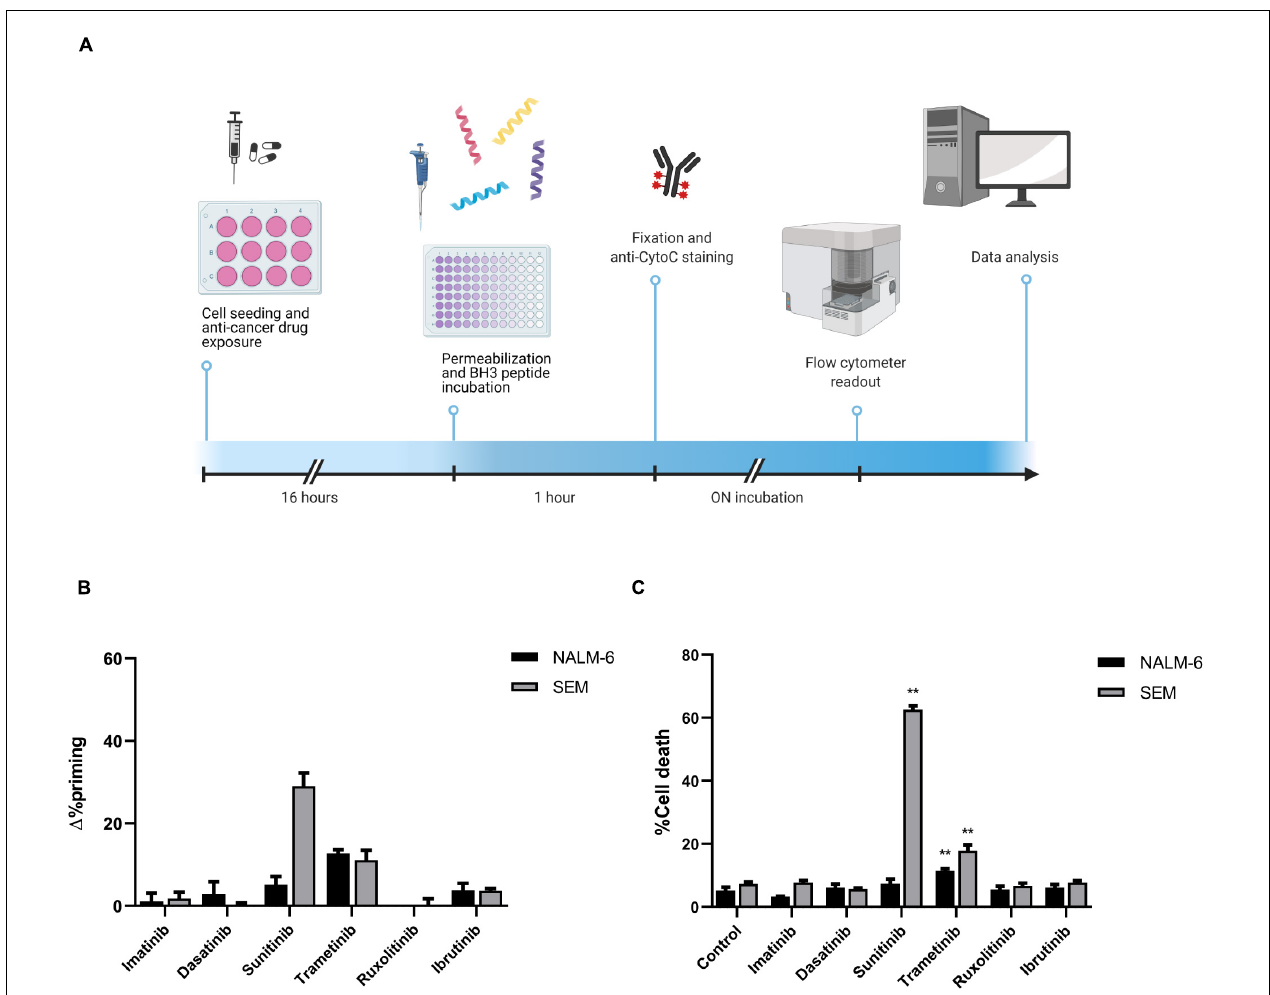
FIGURE 1 | Cytotoxicity induced by targeted drugs in BCP-ALL cell lines. (A) Graphical scheme of the DBP technique where cancer cells are plated and treated for 16 h. After drug exposure, cells are plated in 96-well plates and exposed to the different BH3 peptides. After 1 h, cells were fixed and stained with an anti-Cytochrome C antibody overnight. Finally, analyses were performed using a flow cytometer for drug-response curves. Designed with BioRender.com. (B) DBP with BIM BH3 peptide after 16 h of incubation with 1,000 nM imatinib, 100 nM dasatinib, 1,000 nM sunitinib, 100 nM trametinib, 100 nM ruxolitinib, and 1,000 nM ibrutinib in NALM-6 and SEM cell lines. (cid:49) %priming stands for the difference in %priming between treatment and control conditions. (C) Cytotoxicity expressed as percentage of dead cells after 72 h of treatment with the same therapies assessed by Annexin V/DAPI staining. All results are expressed as the mean ± standard error of the mean (SEM) of at least three biologically independent replicates. Statistical significance was calculated using Student’s t -test comparing to control condition and considering * p < 0.05 and ** p <